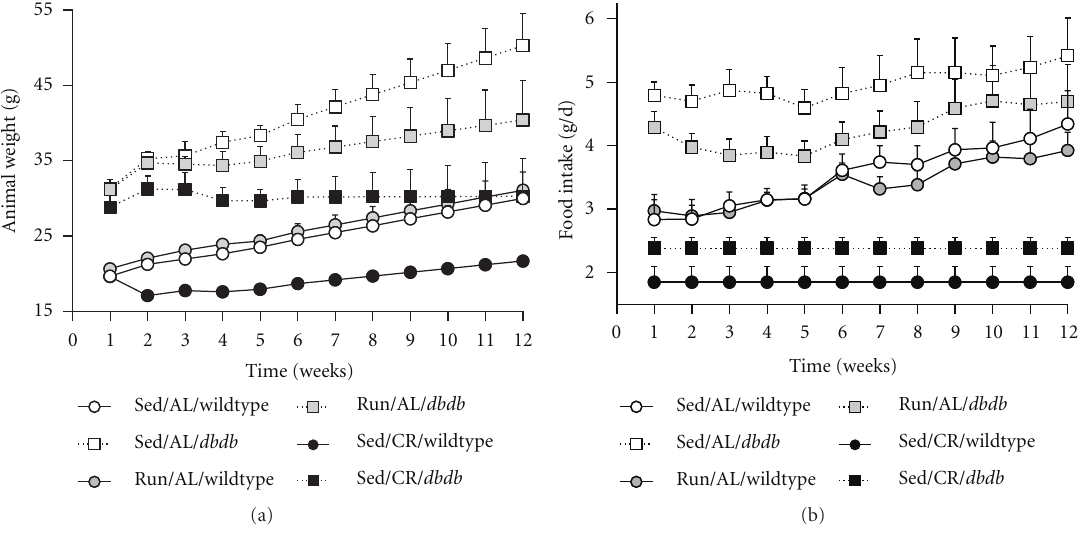
Figure 1: Caloric restriction and wheel running alter body weight gain and food intake in C57Bl/6 and leptin receptor-deficient mice. (a) C57Bl/6 mice maintained on 40% caloric restriction (CR) gain weight more slowly than wild-type mice on the ad libitum (AL) diet. db/db mice maintained on CR from one month of age did not significantly gain weight over the subsequent twelve weeks of the experiment, and voluntary wheel running decelerates body weight gain in db/db mice. (b) Running transiently suppresses food intake in db/db mice. Data were analyzed with 2 × 3 repeated measures ANOVA with Tukey’s post hoc and significance set at P < 0 . 05. Error bars represent